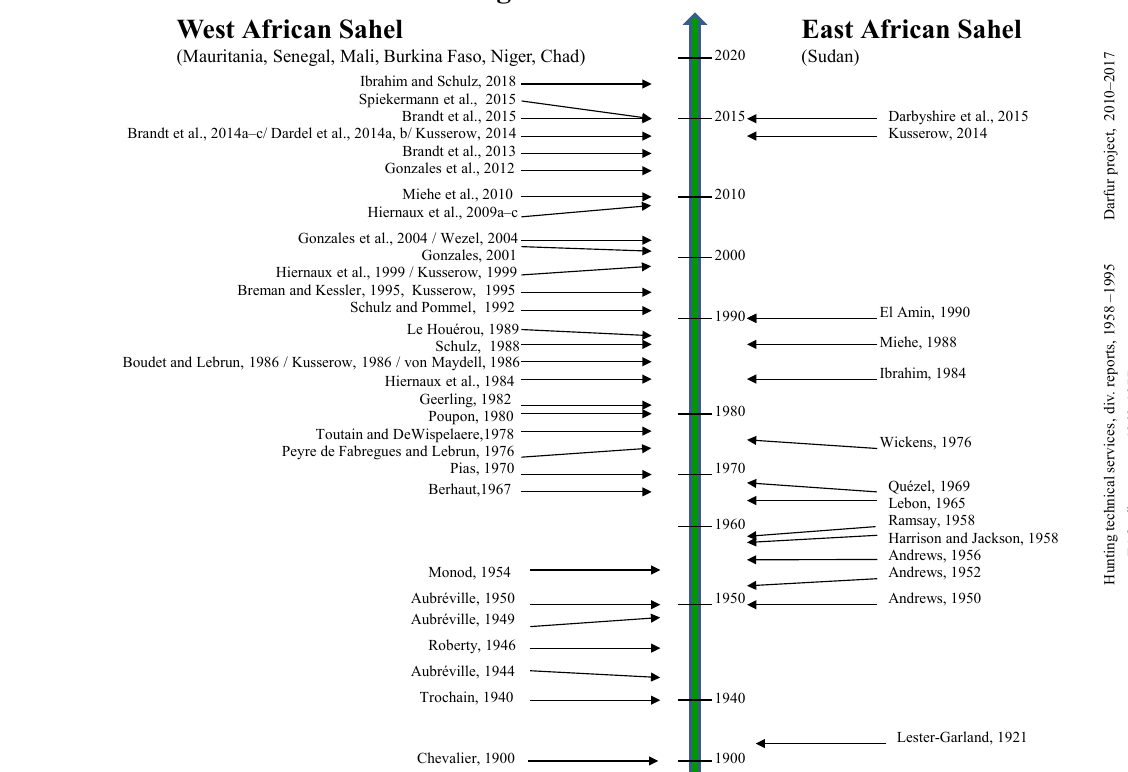
Figure 8. Compilation of selected botanical assessments in the West and the East African Sahel since 1900.